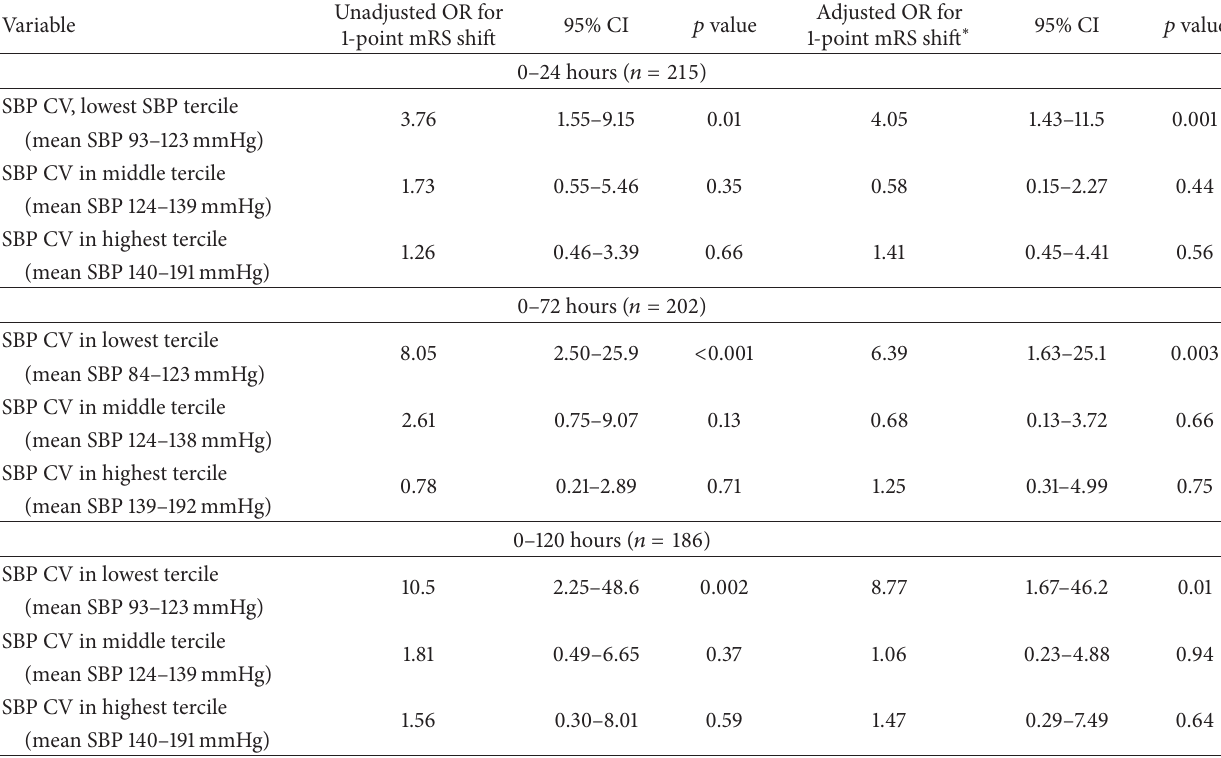
Table 5: Unadjusted and adjusted ordinal logistic regression models fitted to outcome of mRS with main predictor variable of SBP CV, with models stratified by terciles of mean